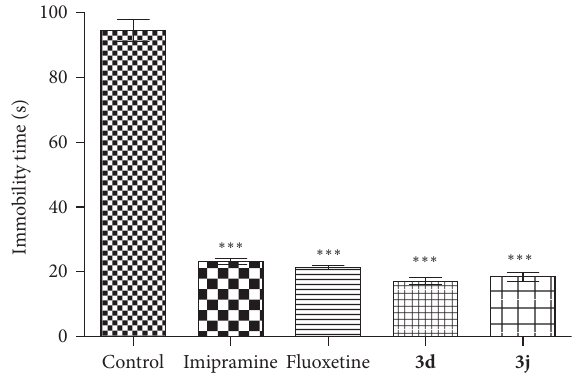
F 1: General structure of proposed scaffold as antidepressant agents.